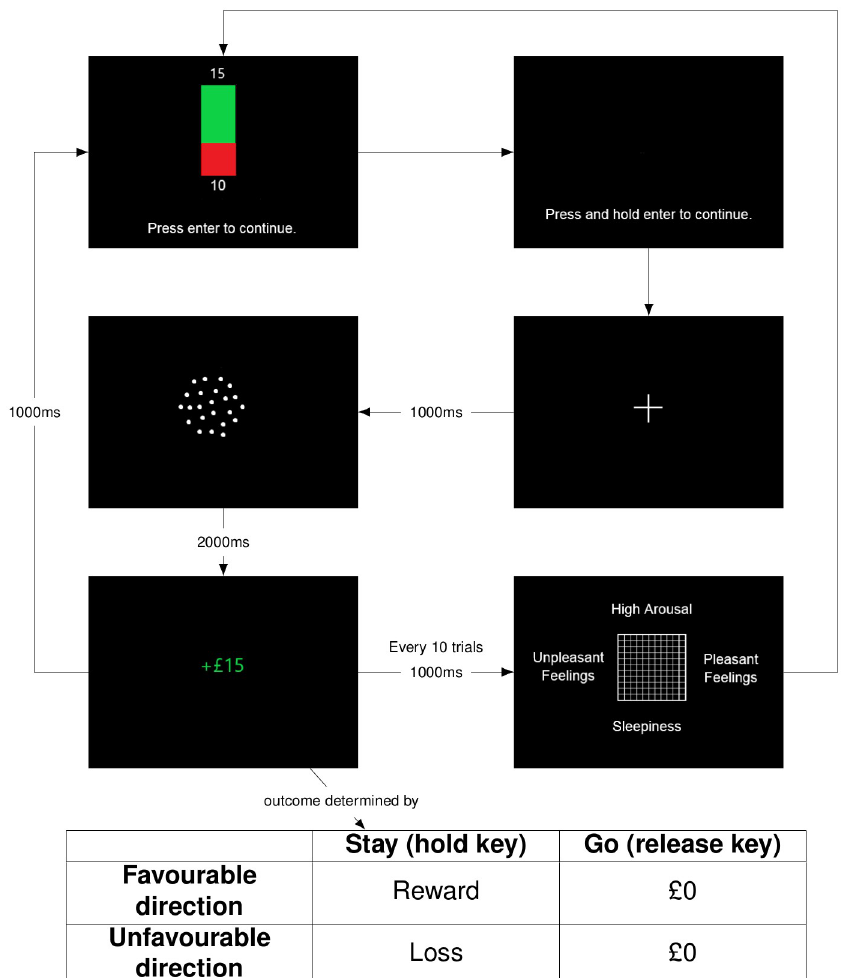
Fig 1. Task structure. Structure of the human monetary judgement bias test session: (1) participants are shown the potential outcomes of the ‘stay’ response and then must press ‘enter’; (2) participants are instructed to press and hold the ‘enter’ key; (3) participants are shown a fixation cross for 1000ms (3) participants are presented with a RDK for 2000ms during which they must either continue holding the ‘enter’ key (‘stay’) or release the ‘enter’ key (‘go’); (4) participants are shown the outcome of their action (which is also determined by the true direction of the RDK) for 1000ms (5) either the next trial starts or the participant is asked to complete an affect grid (after every 10 trials).